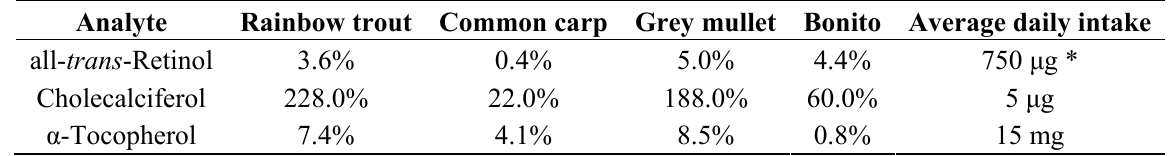
Table 3. Percentage contribution of fat-soluble vitamins from analyzed